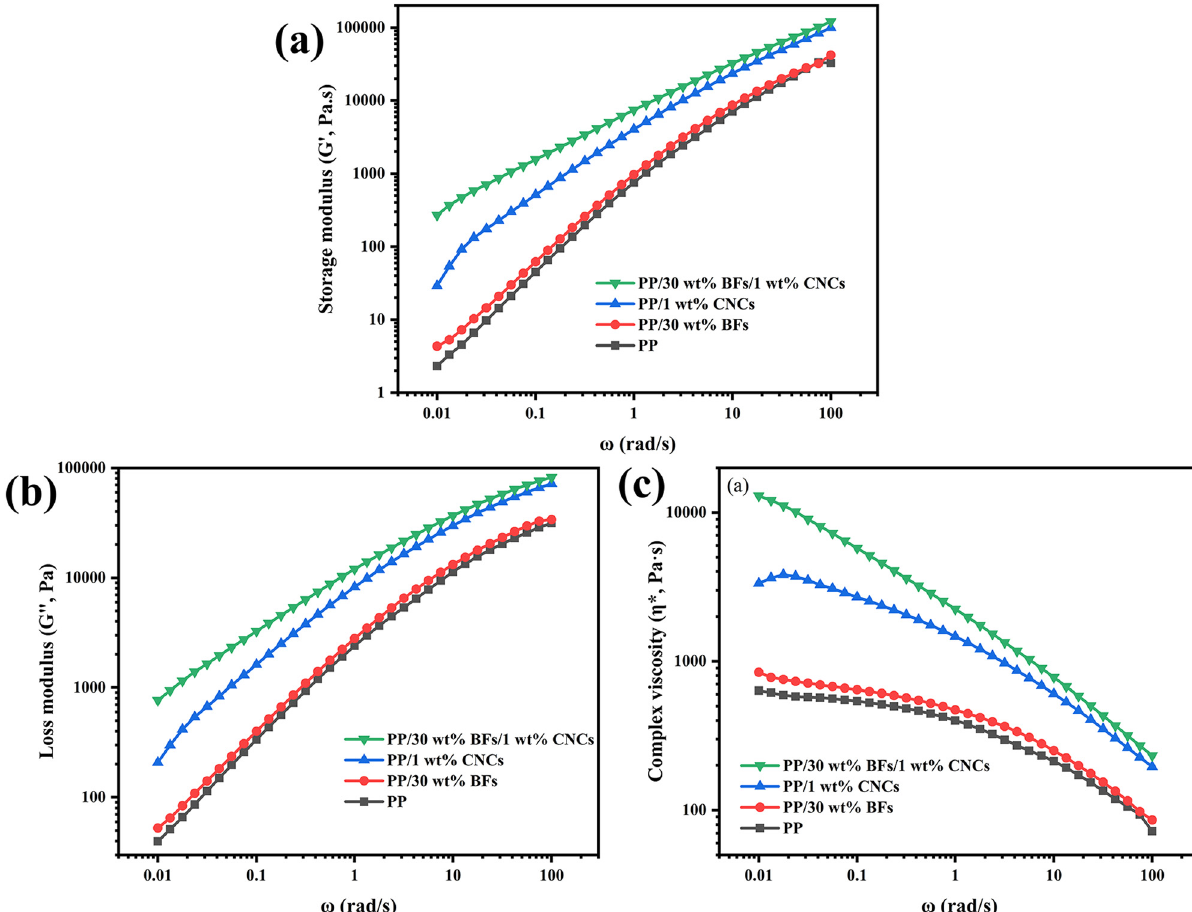
Figure 5: Comparison of storage modulus, loss modulus, and complex viscosity ( η * ) of composites with di ff erent contents of CNCs and BFs from analyzing rheological behaviors: ( a ) storage modulus, ( b ) loss modulus, and ( c ) complex viscosity ( η * ) .